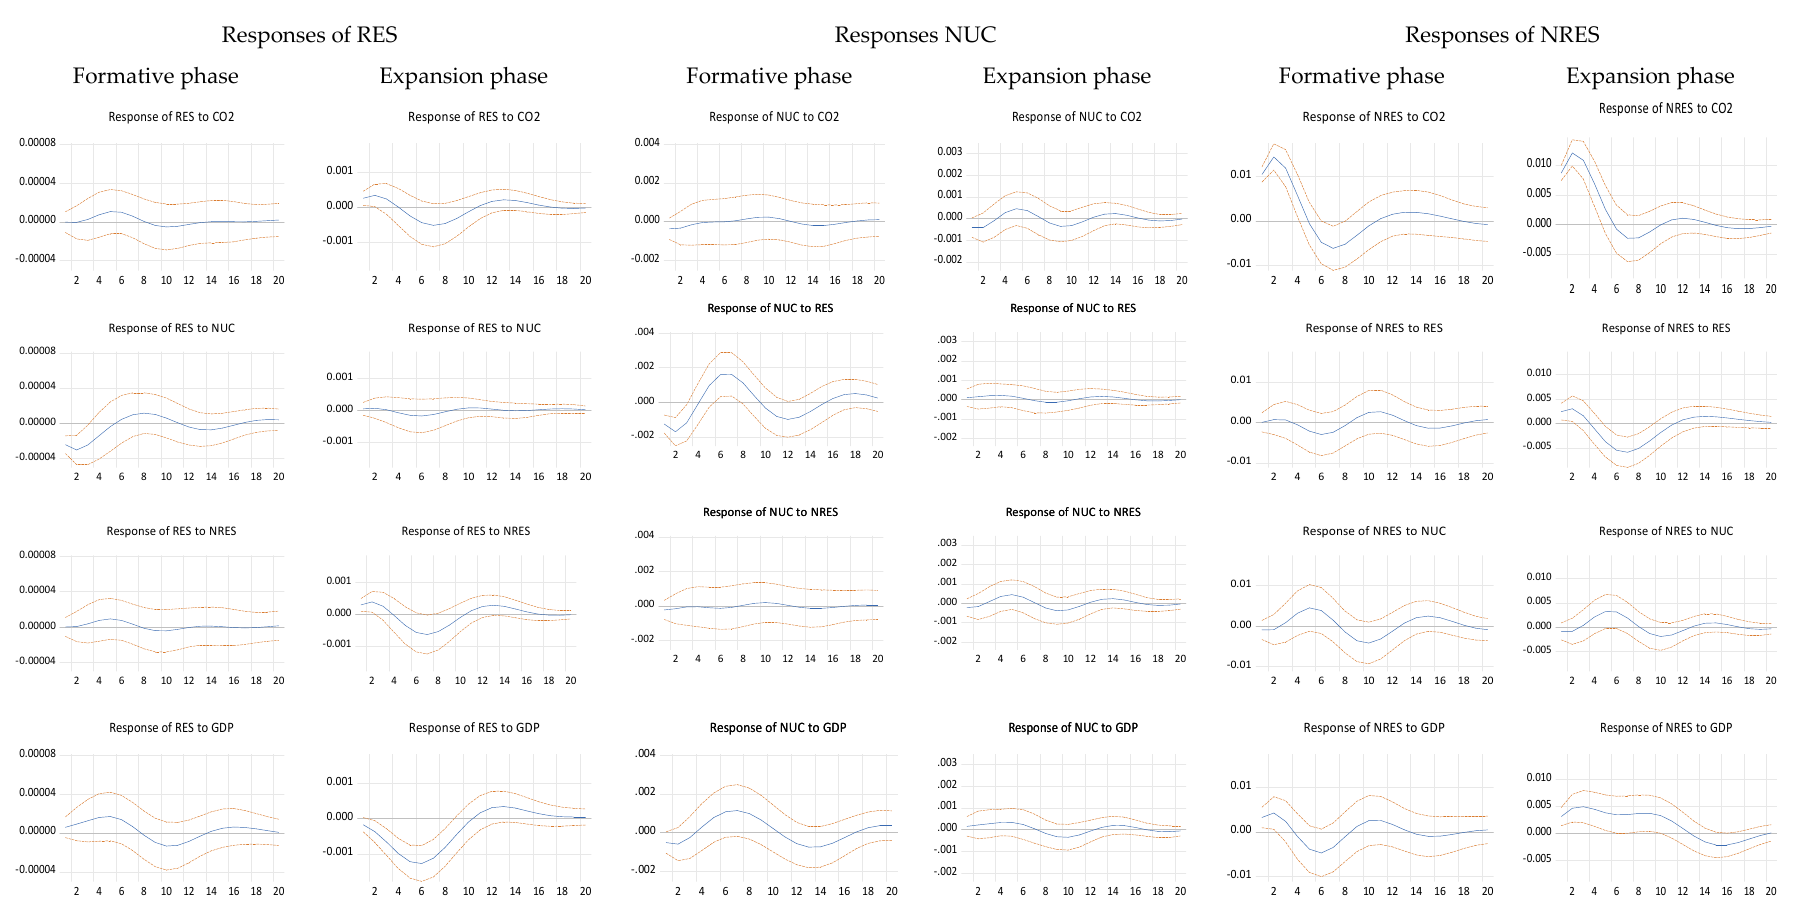
Figure A2. Responses of RES, NUC, and NRES to shocks in variables in the formative and expansion phases in Spain.